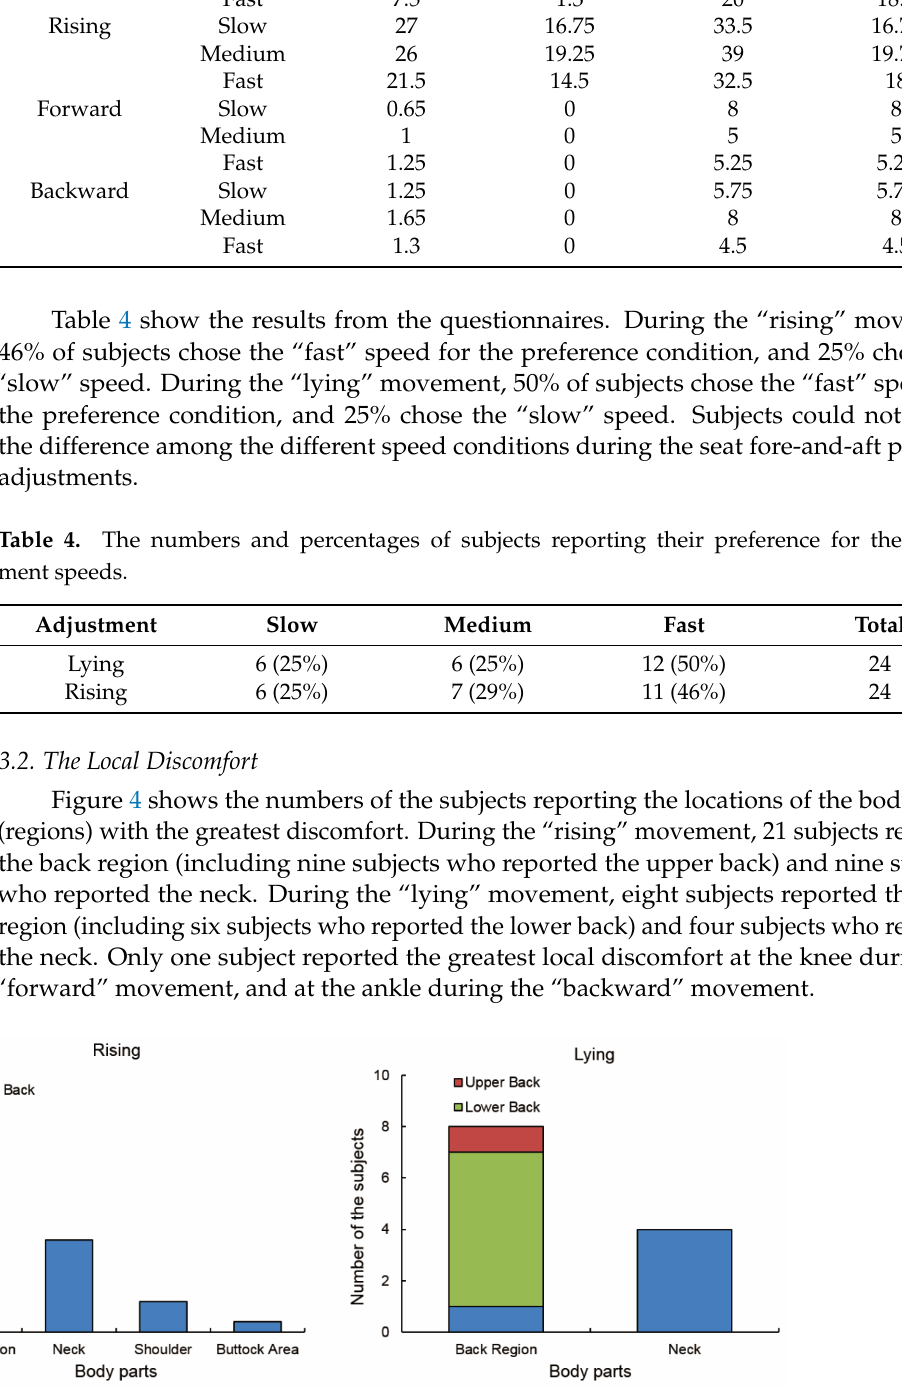
Figure 4. The numbers of the subjects reporting the locations of the body parts with greatest dis- comfort.